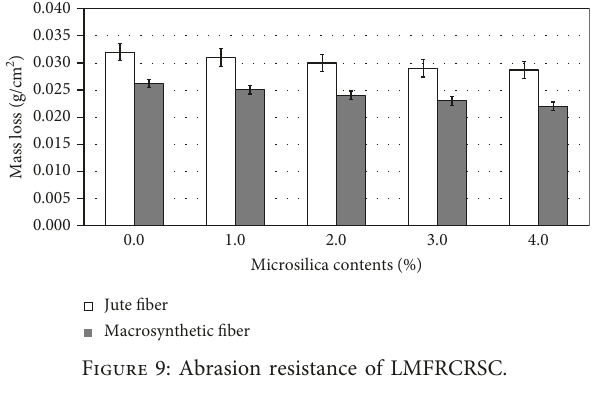
Figure 9: Abrasion resistance of